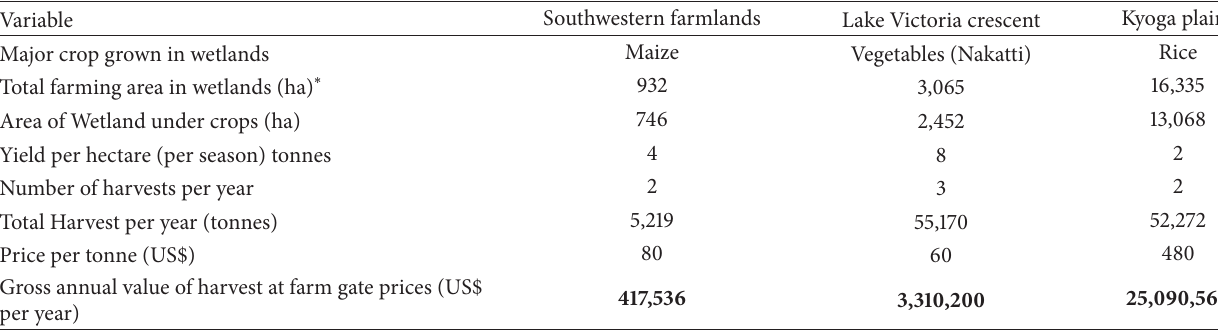
Table 4: Monetary value of wetlands in terms of crop farming in three agro-ecological zones of Uganda. Variable